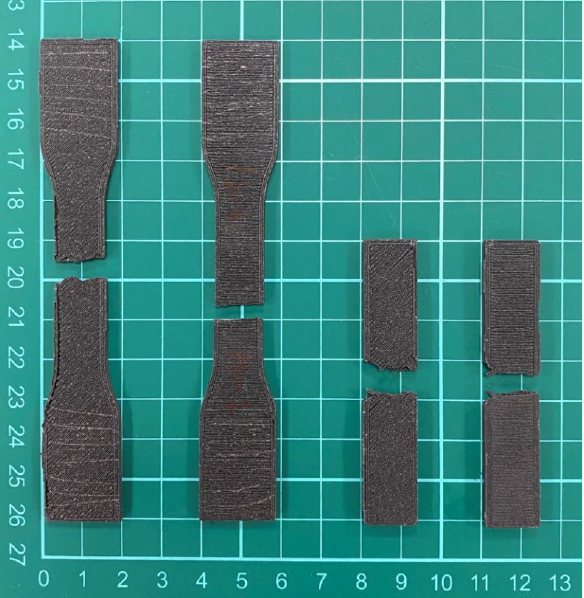
Figure 3. Photo of the fractured specimens.